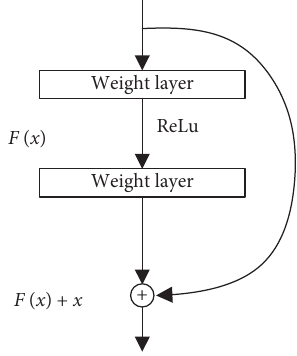
Figure 5: Schematic diagram of the residual